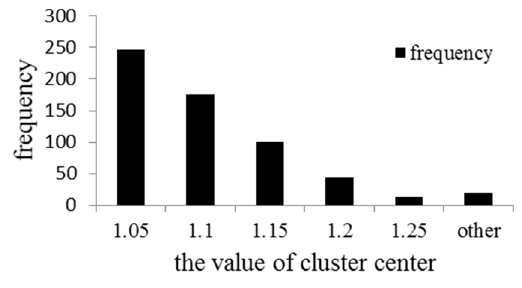
Figure 11. The histogram of cluster center.